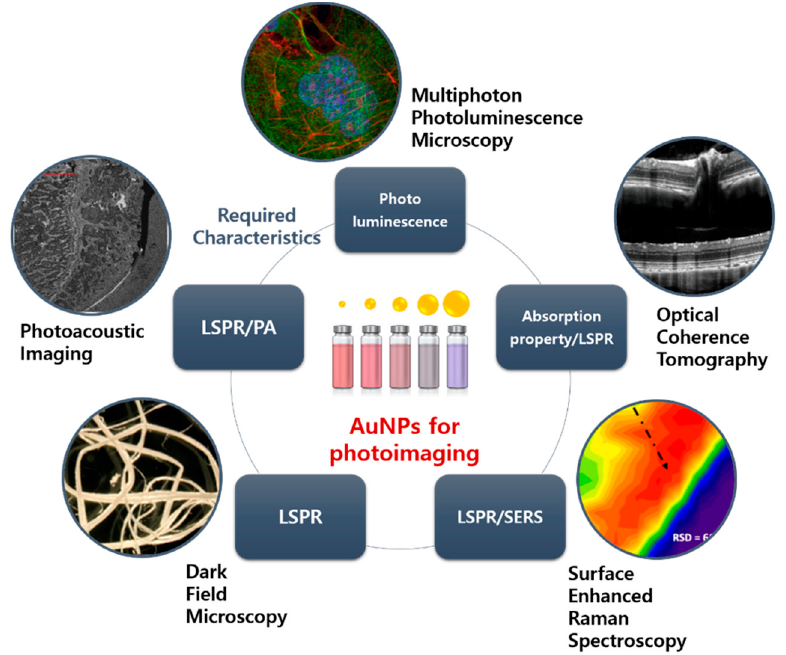
Figure 4. AuNP-based photoimaging. Each imaging system is arranged by required characteristics of AuNP. Image courtesy of Nikon (dark field microscopy), YSP (photoacoustic imaging (PAI)), phoenix (optical coherence tomography (OCT)), ZEISS (multiphoton photoluminescence microscopy), Sigma-Aldrich (surface enhanced Raman scattering (SERS)), respectively.